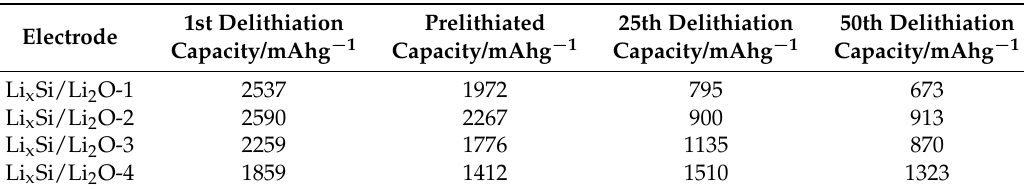
Table 1. Cycling performance for Li x Si/Li 2 O electrodes.